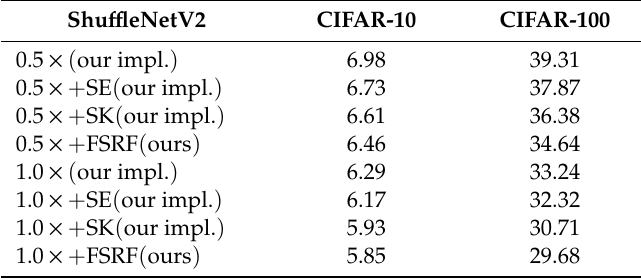
Table 5. Top-1 errors (%) on CIFAR, with all models based on the corresponding Shu ffl eNetV2. Shu ffl